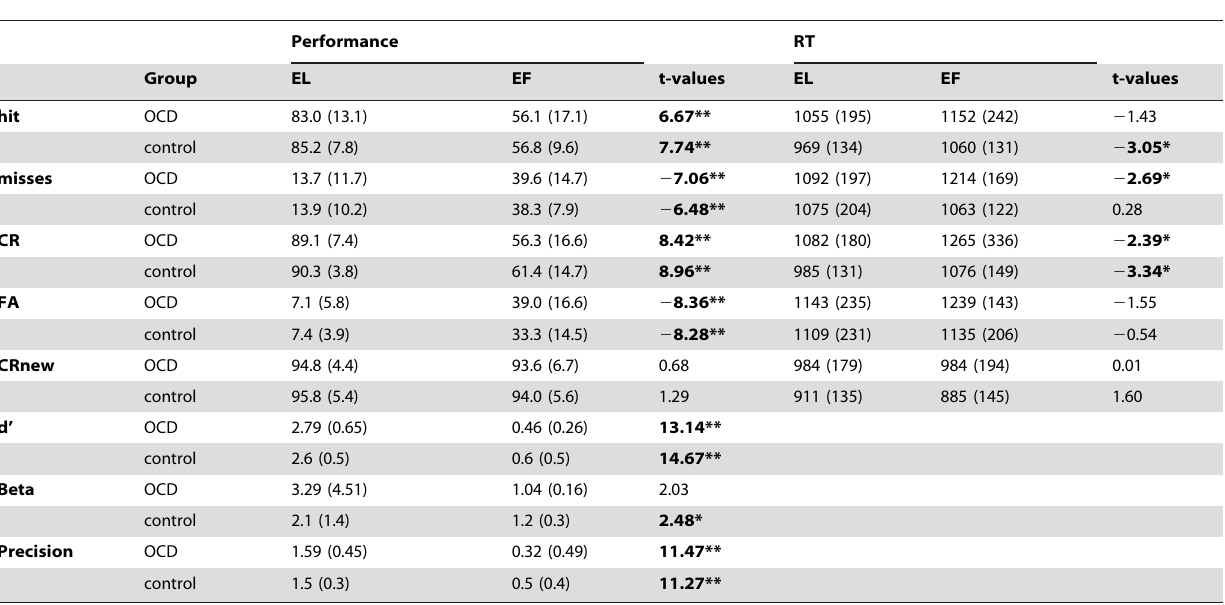
Table 4. Overview of Performance measure (LM